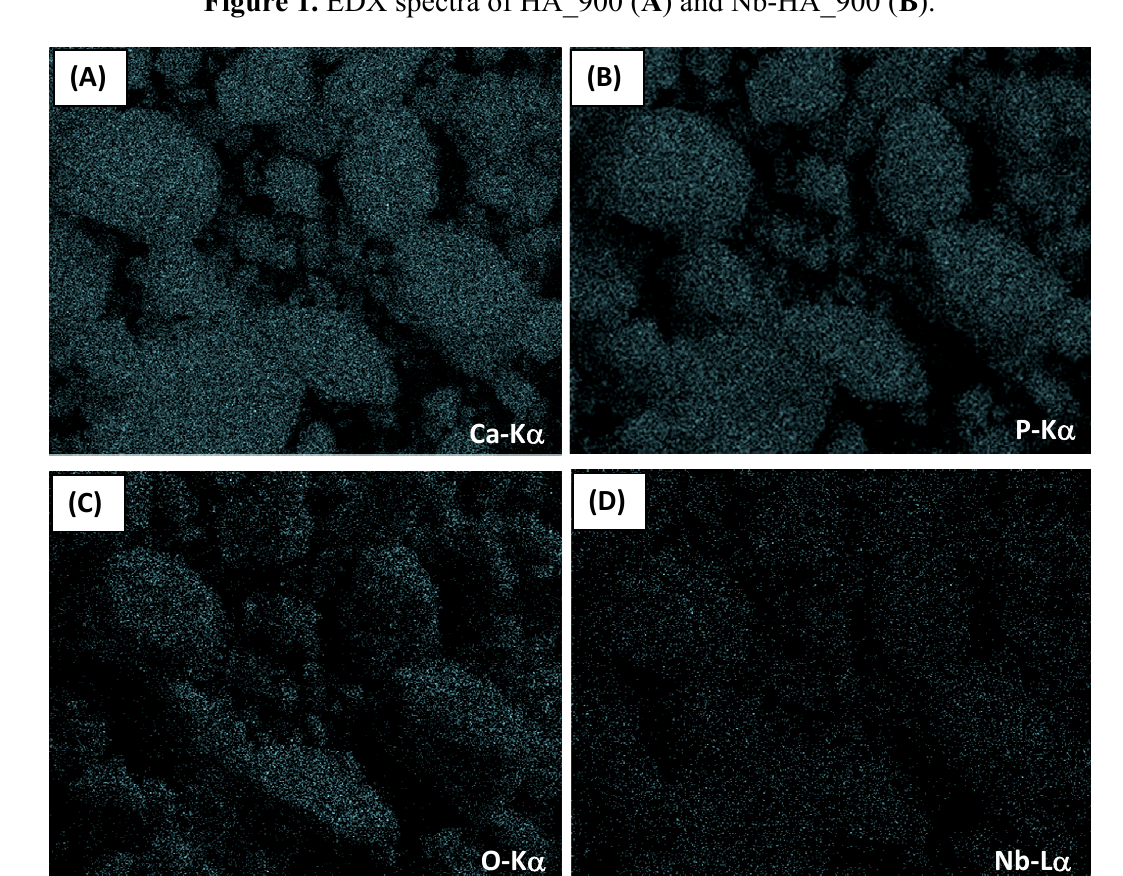
Figure 2. EDX image mapping of Ca (K  ) ( A ); P (K  ) ( B ); O (K  ) ( C ); and Nb (L  ) ( D ) in Nb-HA_900 sample (magnification,